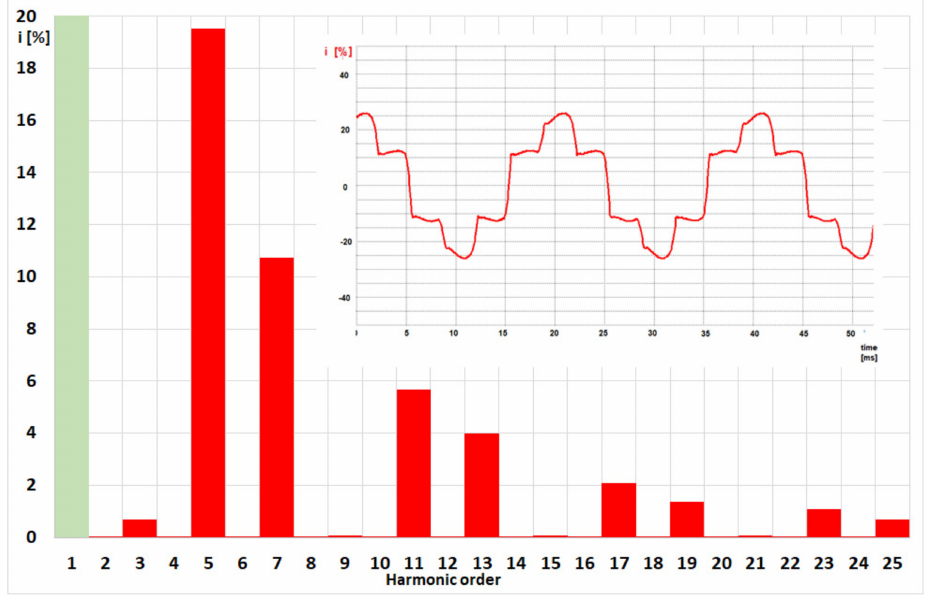
Figure 7. Spectrum of current harmonics and current waveform recorded at point A’. Comparing the percentage content of individual current harmonics recorded in points A and A (cid:48) —Figure 8, it was found: the presence of characteristic harmonics for six-pulse converters, i.e., 5, 7, 11, 13, 17, 19, 23, 24 etc., a significant reduction in the content of higher harmonics current with increasing short-circuit power (between points A and A (cid:48) ).